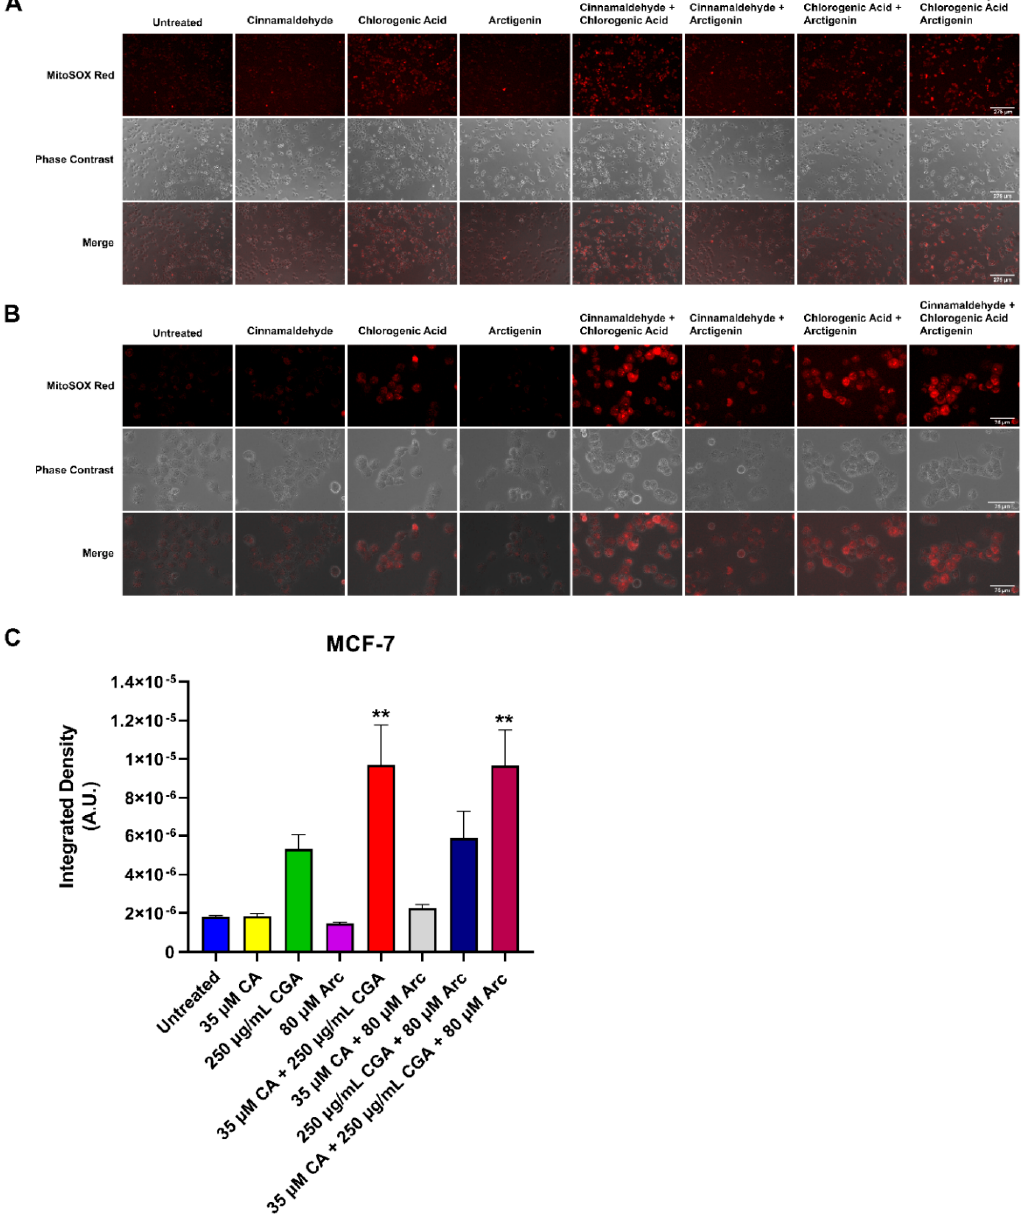
Figure 10. Superoxide production in MCF-7 breast cancer cells treated with 35 µ M CA, 250 µ g/mL CGA, and 80 µ M Arc, alone and in combination, for 2 h. ( A ) Representative fluorescence microscopy images of MCF-7 cells treated with CA, CGA, and Arc, alone and in combination, for 2 h at 10 × magnification (scale bar = 275 µ m). ( B ) Representative fluorescence microscopy images of MCF-7 cells treated with